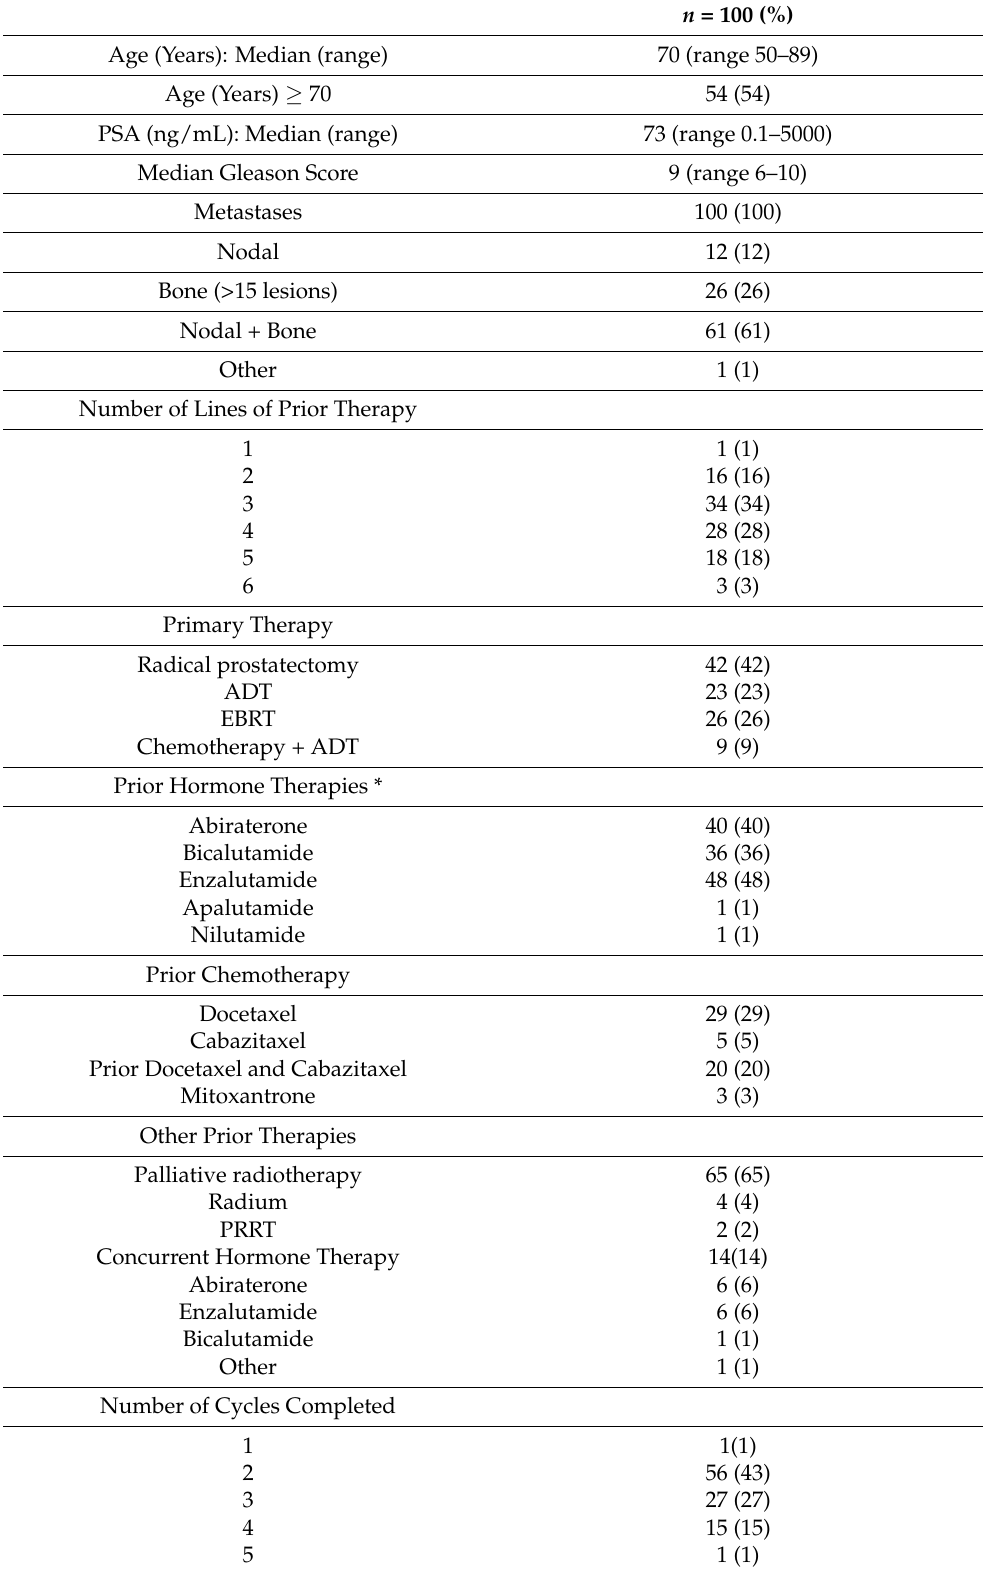
Table 1. Patient